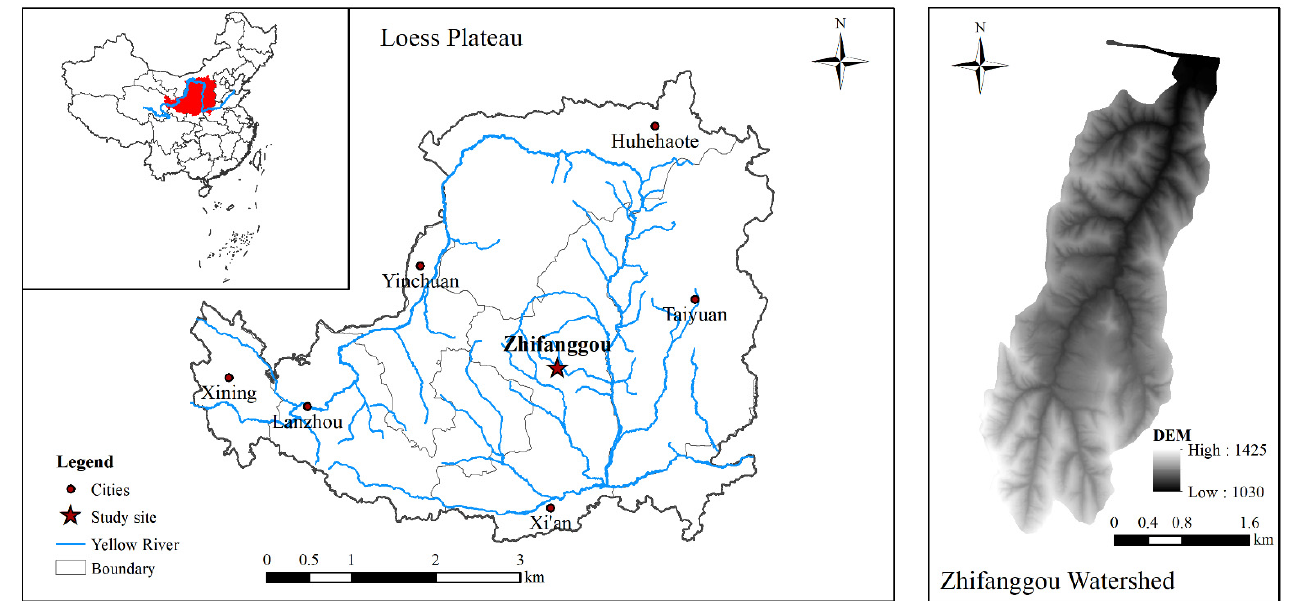
Figure 1. Location of the Zhifanggou watershed on the Loess Plateau, China.